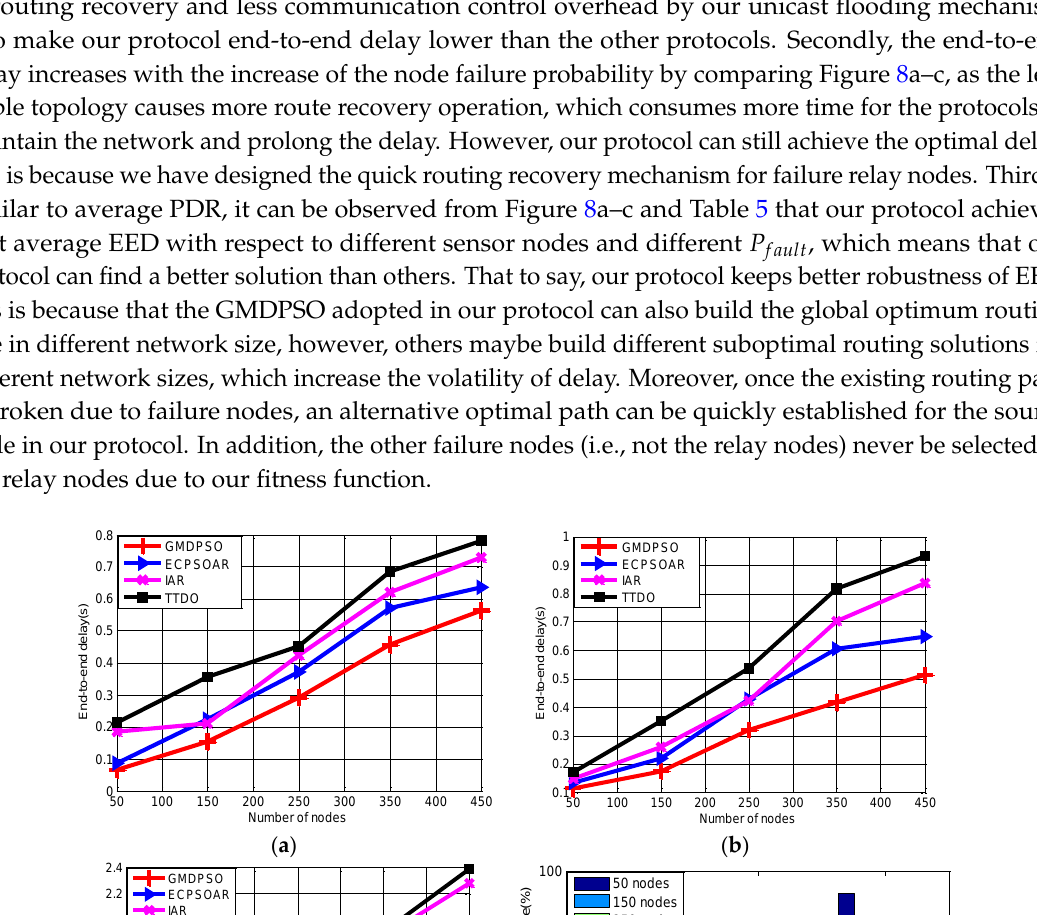
Table 4. Average packet delivery ratio (PDR) with respect to different 𝑃 𝑓𝑎𝑢𝑙𝑡 .